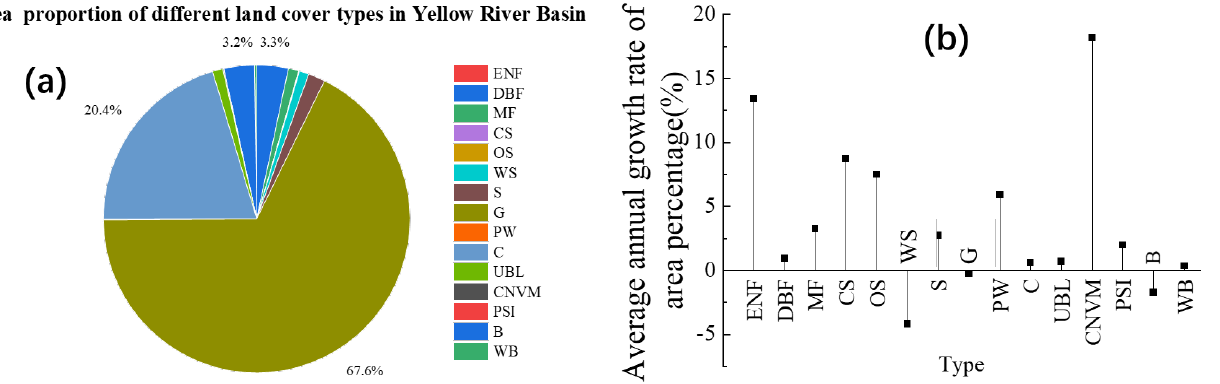
Figure A2. The annual ( a ), ( b ), and ( c ) and monthly ( d ) variations in mean GPP values (sourced from MOD17A2H) in the sub-basins of the YRB; Upper YRB: ( a ); Middle YRB: ( b ); Lower YRB: ( c ).